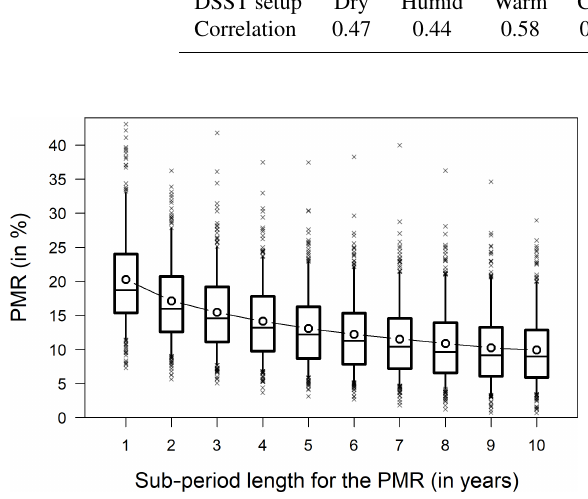
Figure 6. Distribution of PMR values on our catchment set for dif- ferent sub-periods lengths from 1 to 10 years. The model is cali- brated on the whole time series. Black circles indicate the average PMR value.